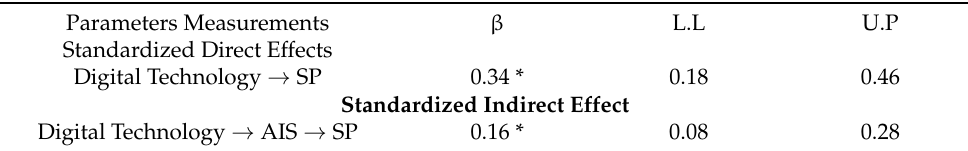
Table 4. Direct and Indirect Effect.